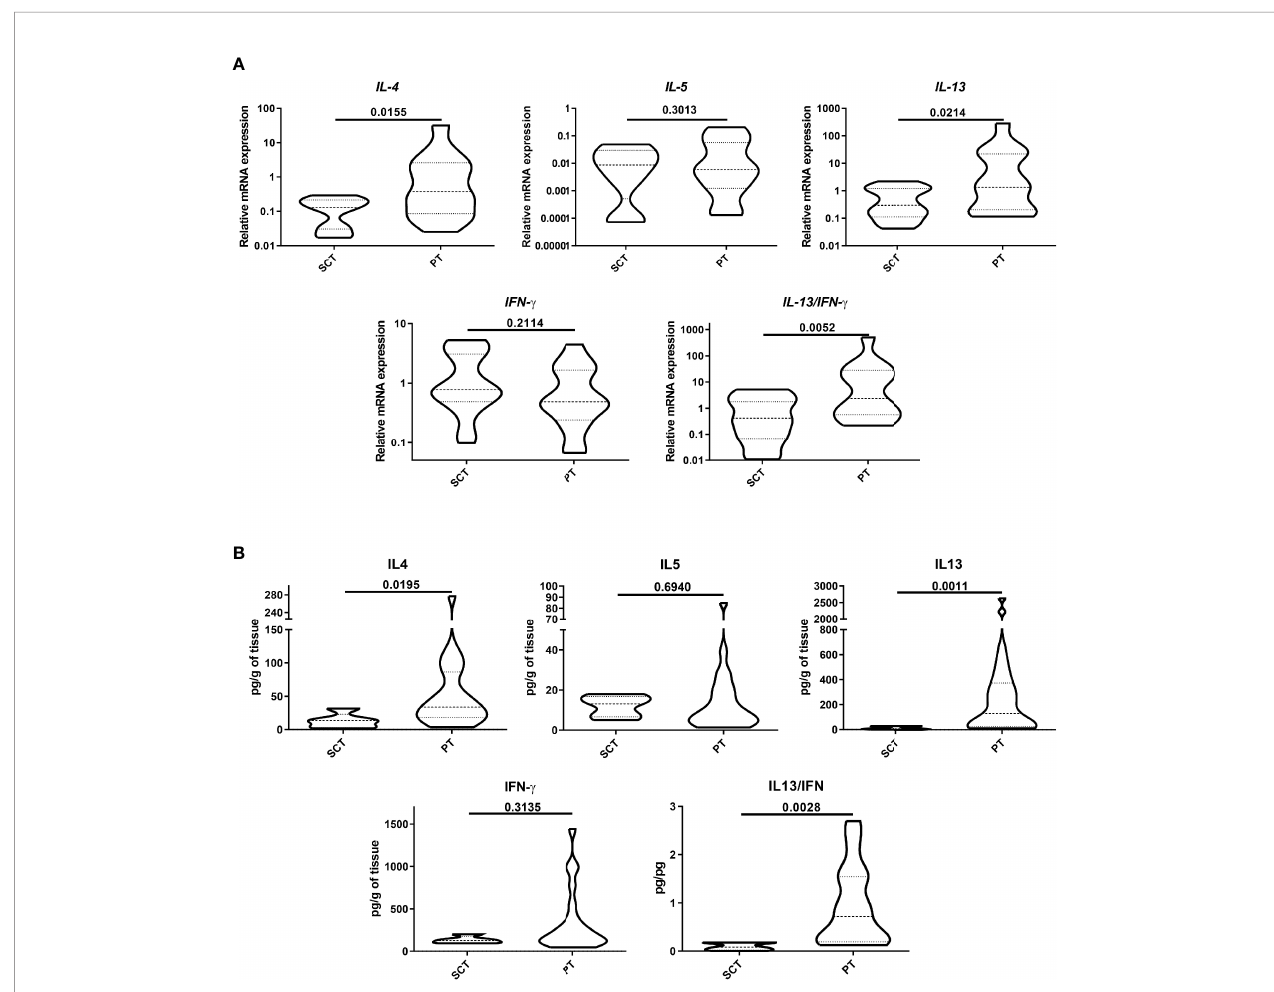
FIGURE 2 | Analysis of cytokine production. Protein expression (A) and quanti fi cation (B) of type-1 and -2 cytokines were analyzed by RT-qPCR and ELISA in tissue lysates. Data are expressed as the mean value ± SEM. Statistic differences were calculated using Student´s t -test.